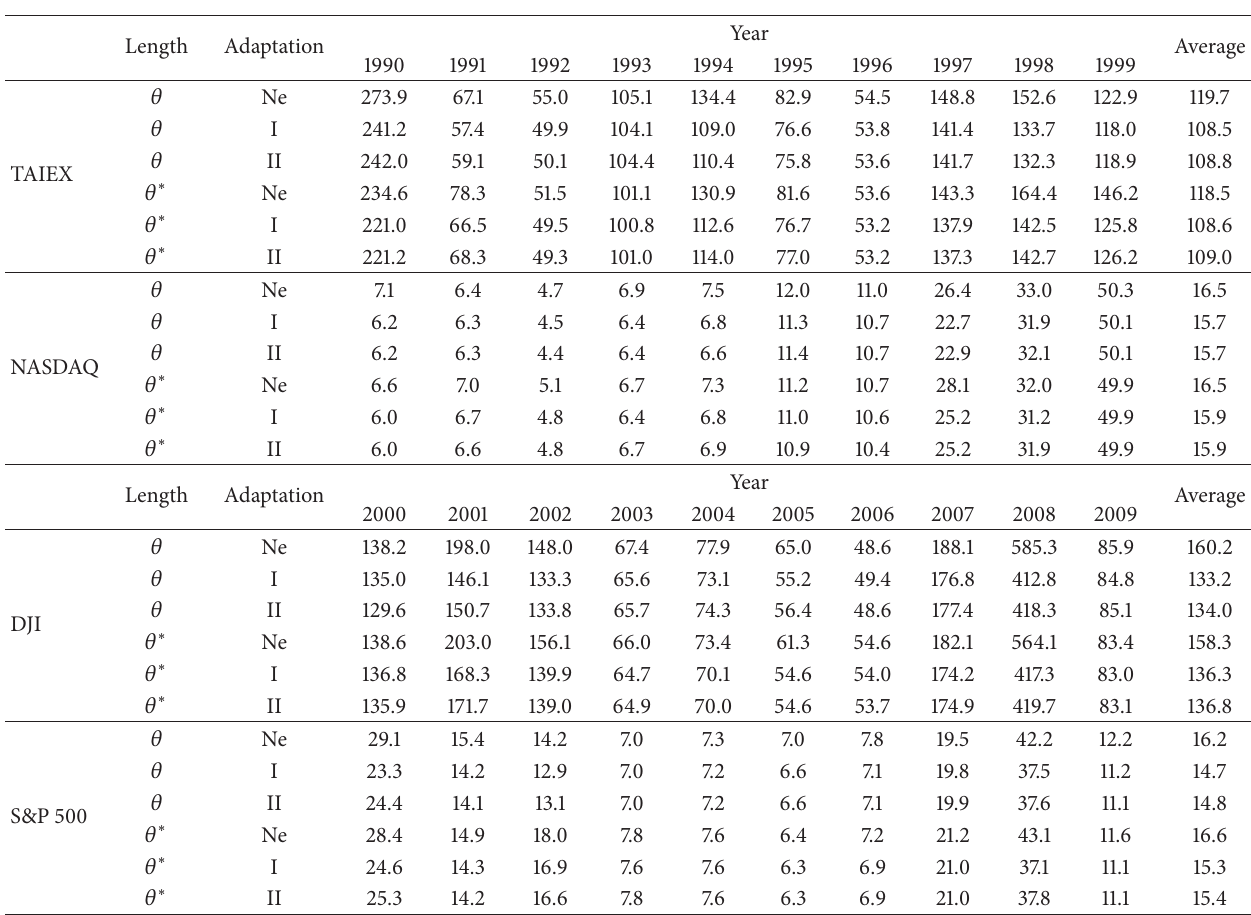
Table 4: Different results on TAIEX, NASDAQ, DJI, and S&P 500 for original data (Yu [22]). Length